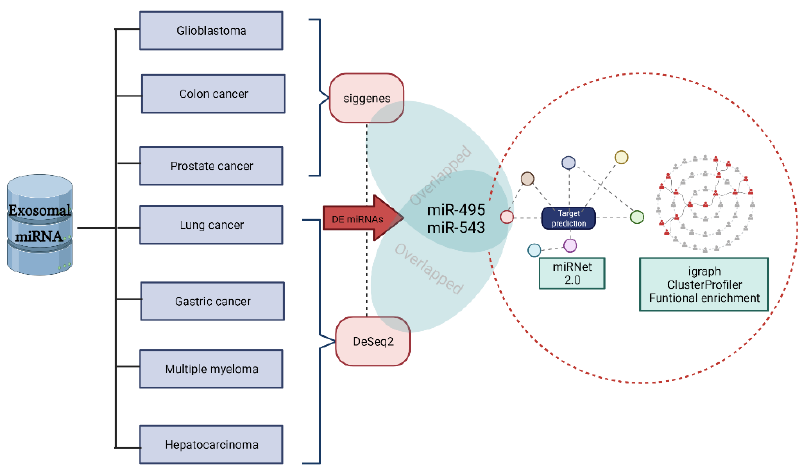
Figure 3. Flowchart of the pipeline employed for the multi-cancer exosomal miRNA study.